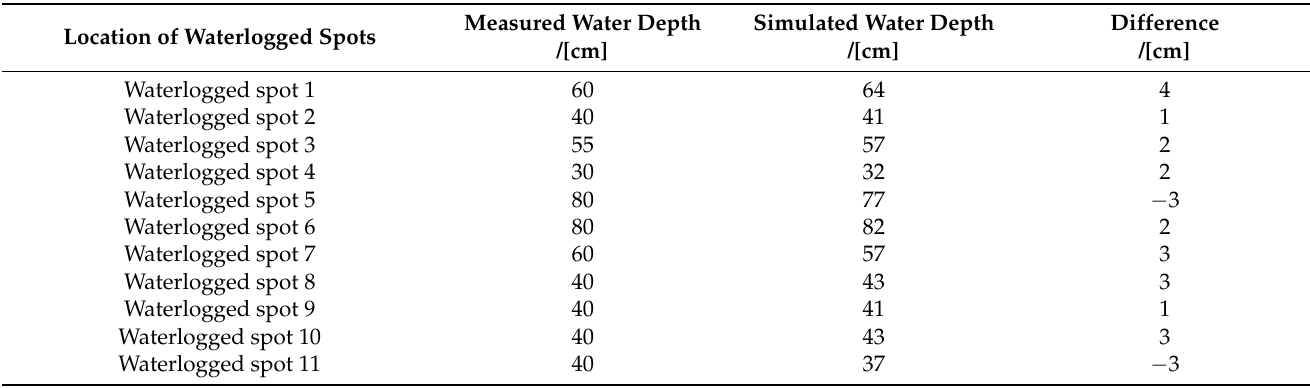
Table 1. Comparison of measured and numerically modelled ponding depths at inundated water points for 20 July